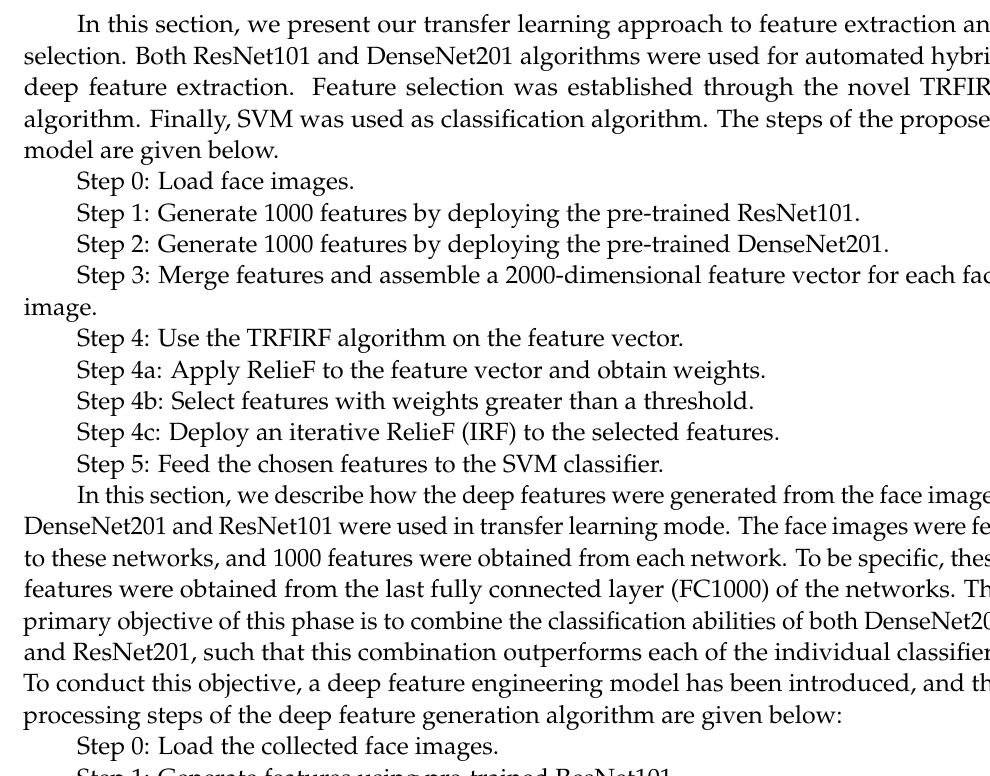
Figure 3. ResNet101 and DenseNet201 deep network architectures.